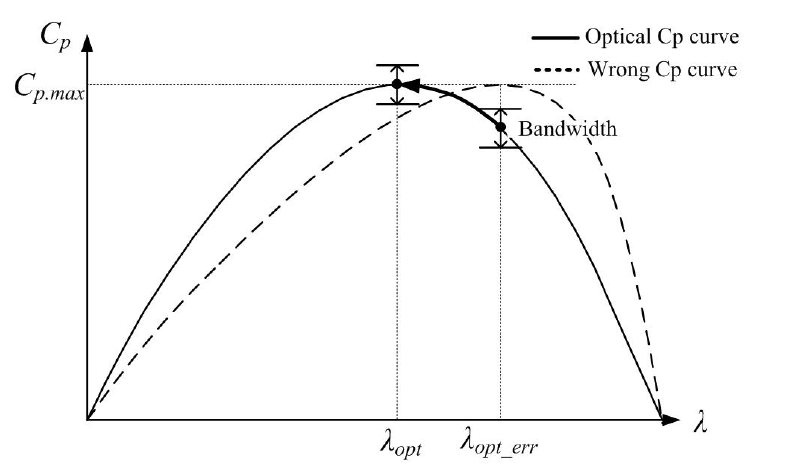
Figure 7. The mechanism of hysteresis